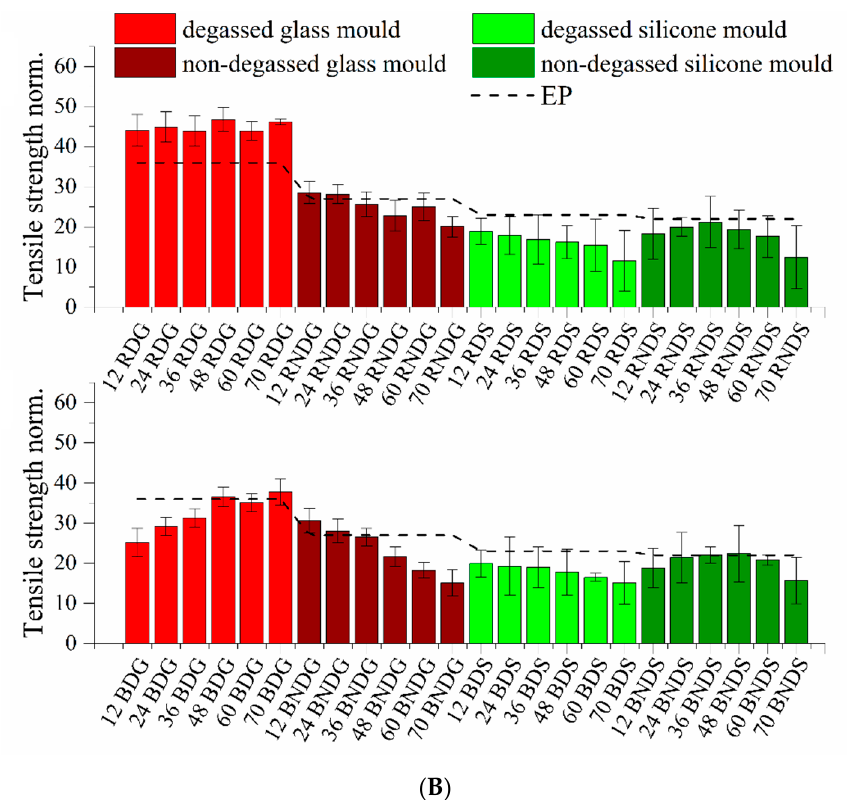
Figure 12. ( A ) Tensile strength for degassed and non-degassed composites containing base diatoms and rinsed diatoms. ( B ) Tensile strength for degassed and non-degassed composites containing base diatoms and rinsed diatoms, density normalized.